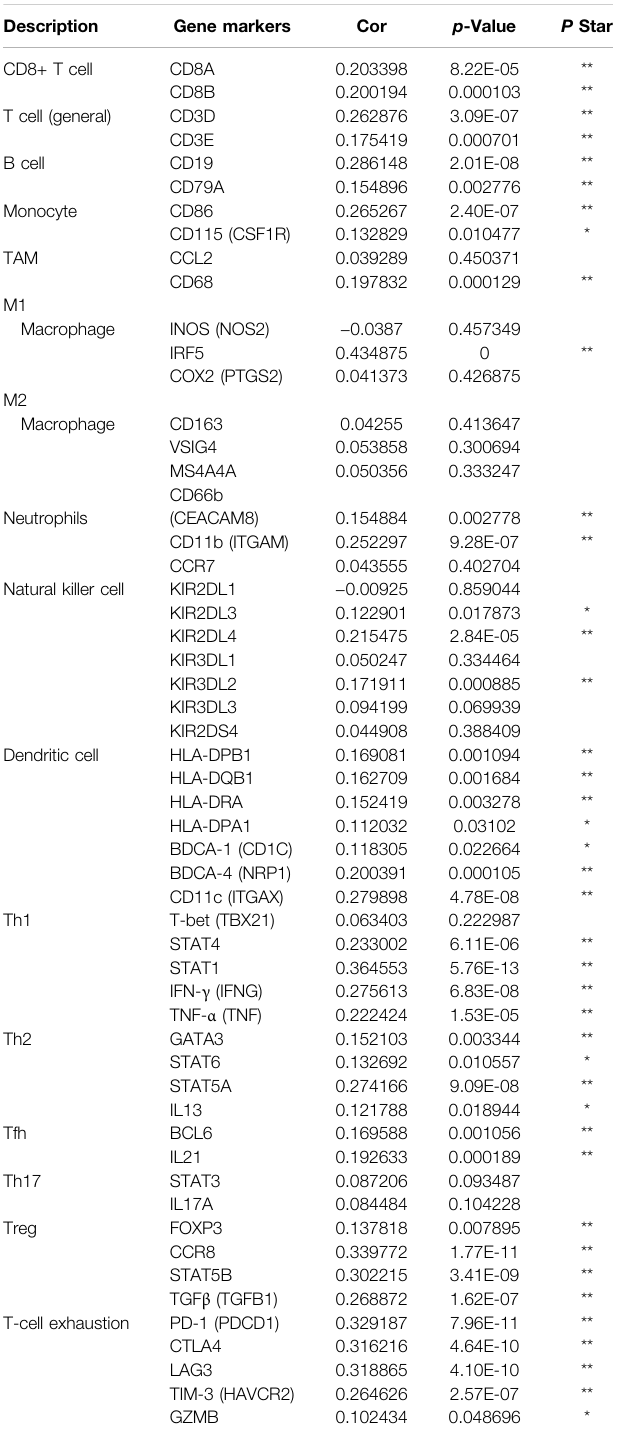
TABLE 1 | Correlation between KIFC1 and immune cell markers for